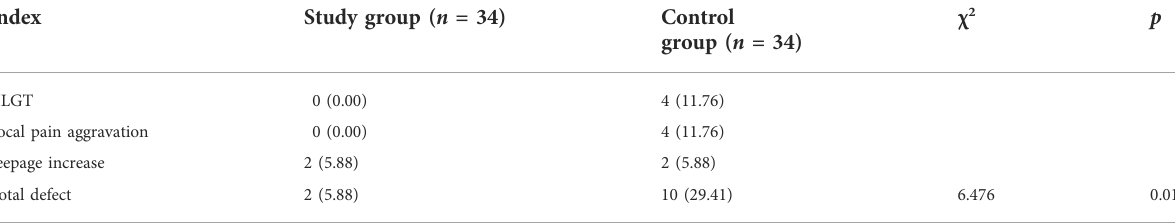
TABLE 3 Comparisons of the incidence of adverse reactions between two groups, n (%).